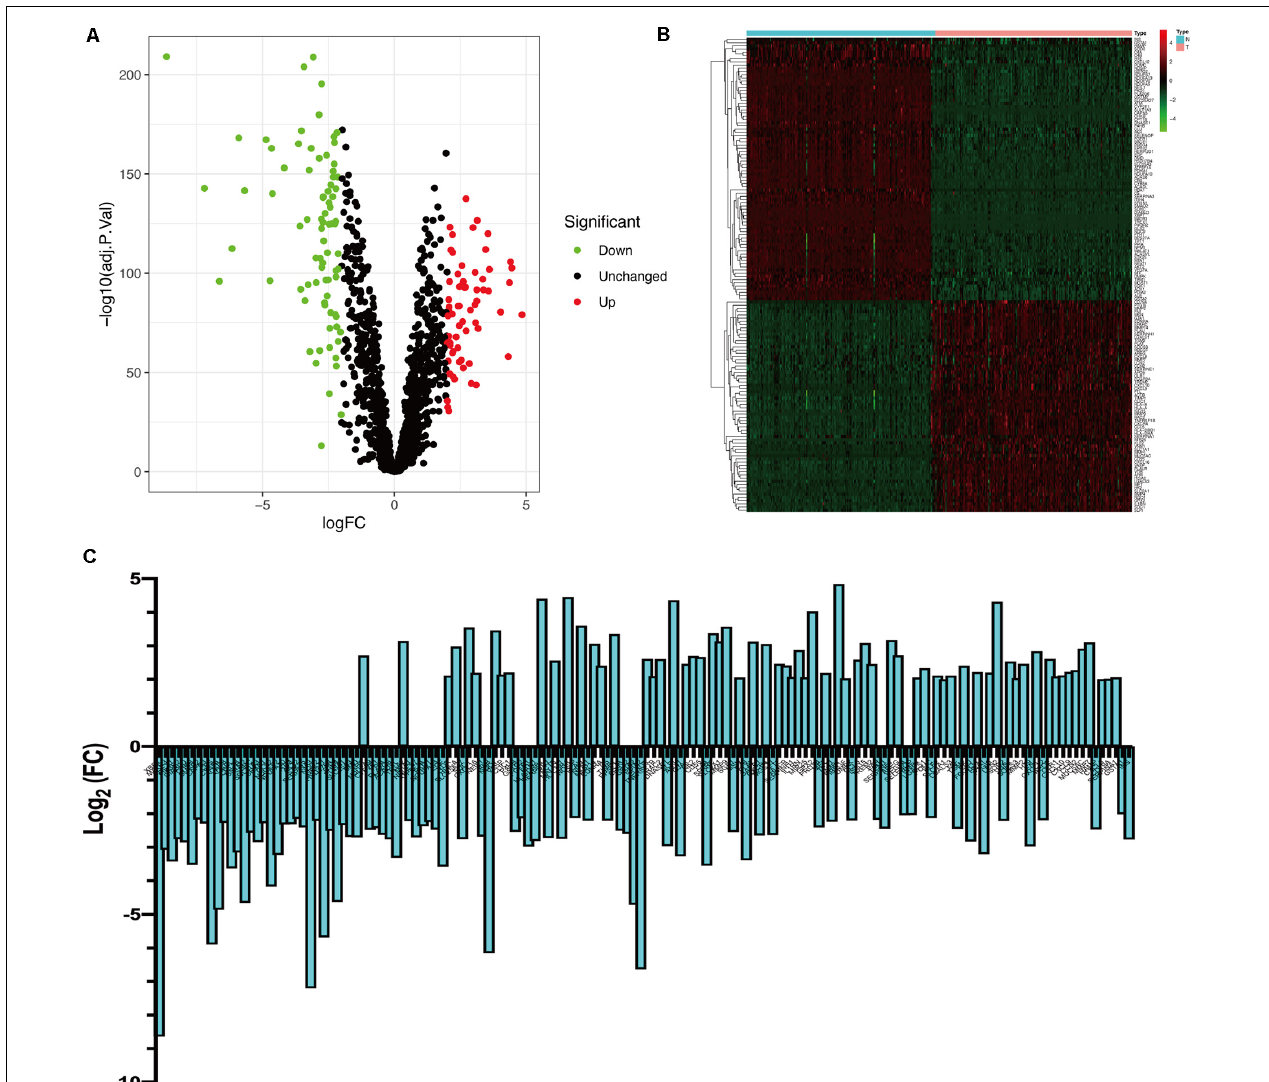
FIGURE 2 | Identification of differently expressed OS genes. (A) Volcano plot of DEOGs between TCGA-PC and GTEx-pancreas cohorts. (B) Heatmap of DEOGs. (C) Histogram of